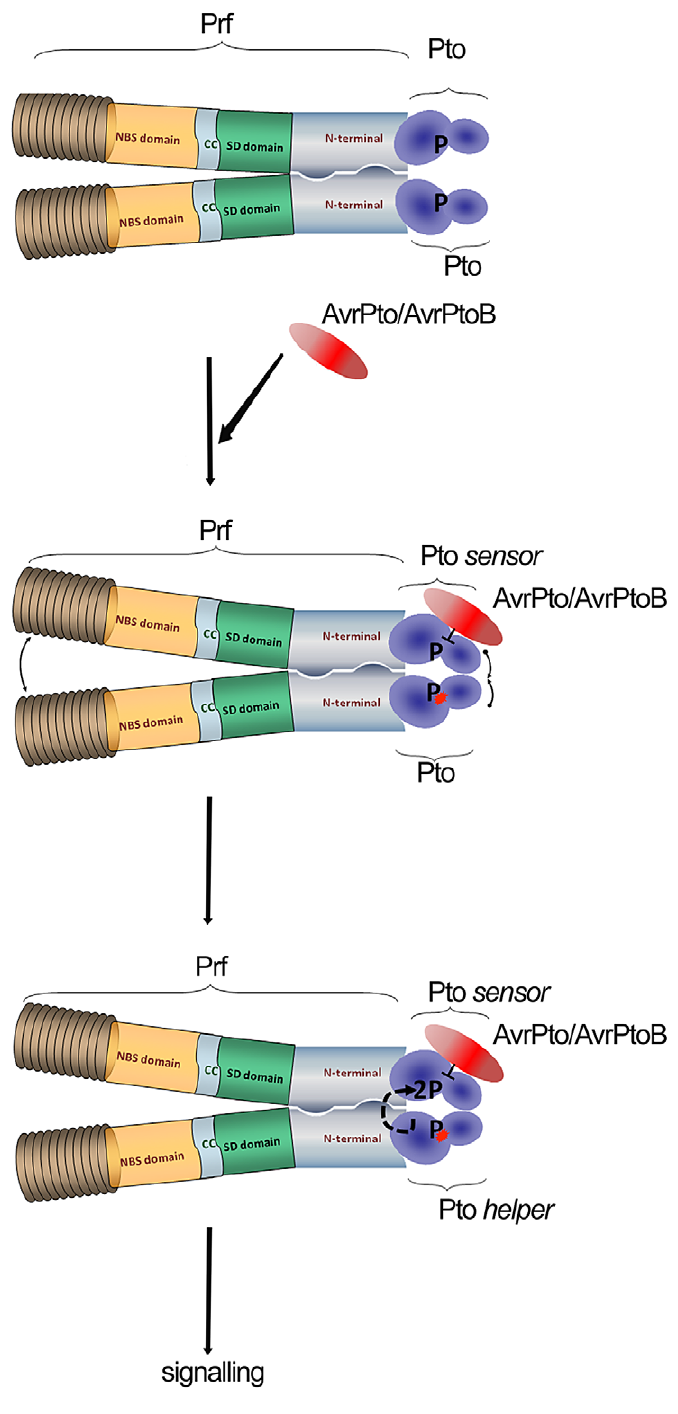
Figure 5. Model of sensor and helper kinases. Dimerization of the NB-LRR protein Prf bring into proximity two molecules of Pto kinase (sensor and helper). Binding of AvrPto/AvrPtoB to previously phosphorylated Pto-sensor molecule disrupts the P + 1 loop and hence negative regulation imposed by Prf. Derepression of the P + 1 loop activates a second Pto-helper molecule in the Prf complex that transphosphorylates the first sensor- kinase, leading to complex activation. doi:10.1371/journal.ppat.1003123.g005 200 m g/mL FLAG peptide (Sigma) for 10 min at 25 u C with gentle mixing. To concentrate elutions, Strataclean (Stratagene) beads were added to bind proteins, and then pelleted by centrifugation subsequently the proteins were stripped from the beads by boiling in 1 6 SDS-PAGE loading buffer.